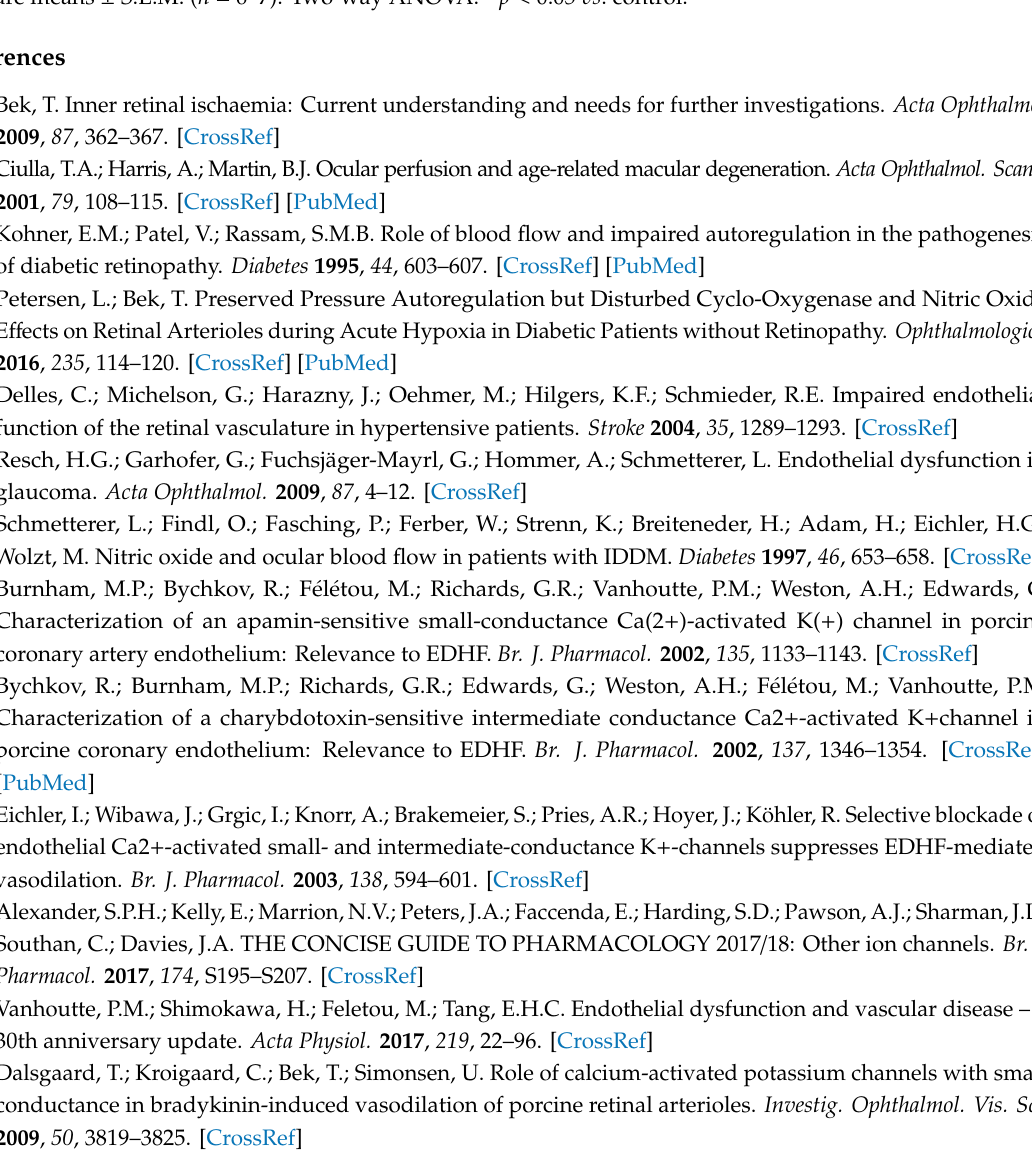
Figure A2. Bradykinin-induced relaxation in the absence and presence of L -arginine (100 µM) and CyPPA (6 µM), an activator of SKCa2-3 channels, in U46619-contracted porcine retinal arterioles. Data are means ± S.E.M. (n = 6–7). Two-way ANOVA. * p <0.05 vs . control.